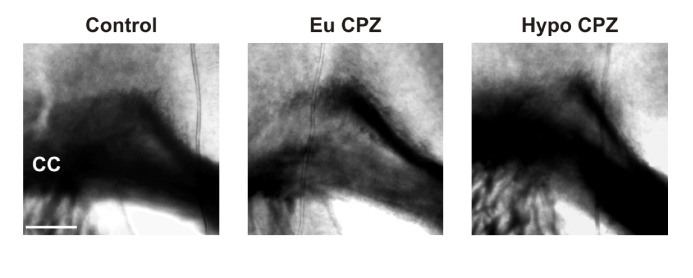
Differential interference contrast image (coronal view) of recorded acute slices from control, EuCPZ and HypoCPZ groups.CC = corpus callosum. Scale bar: 200 µm.